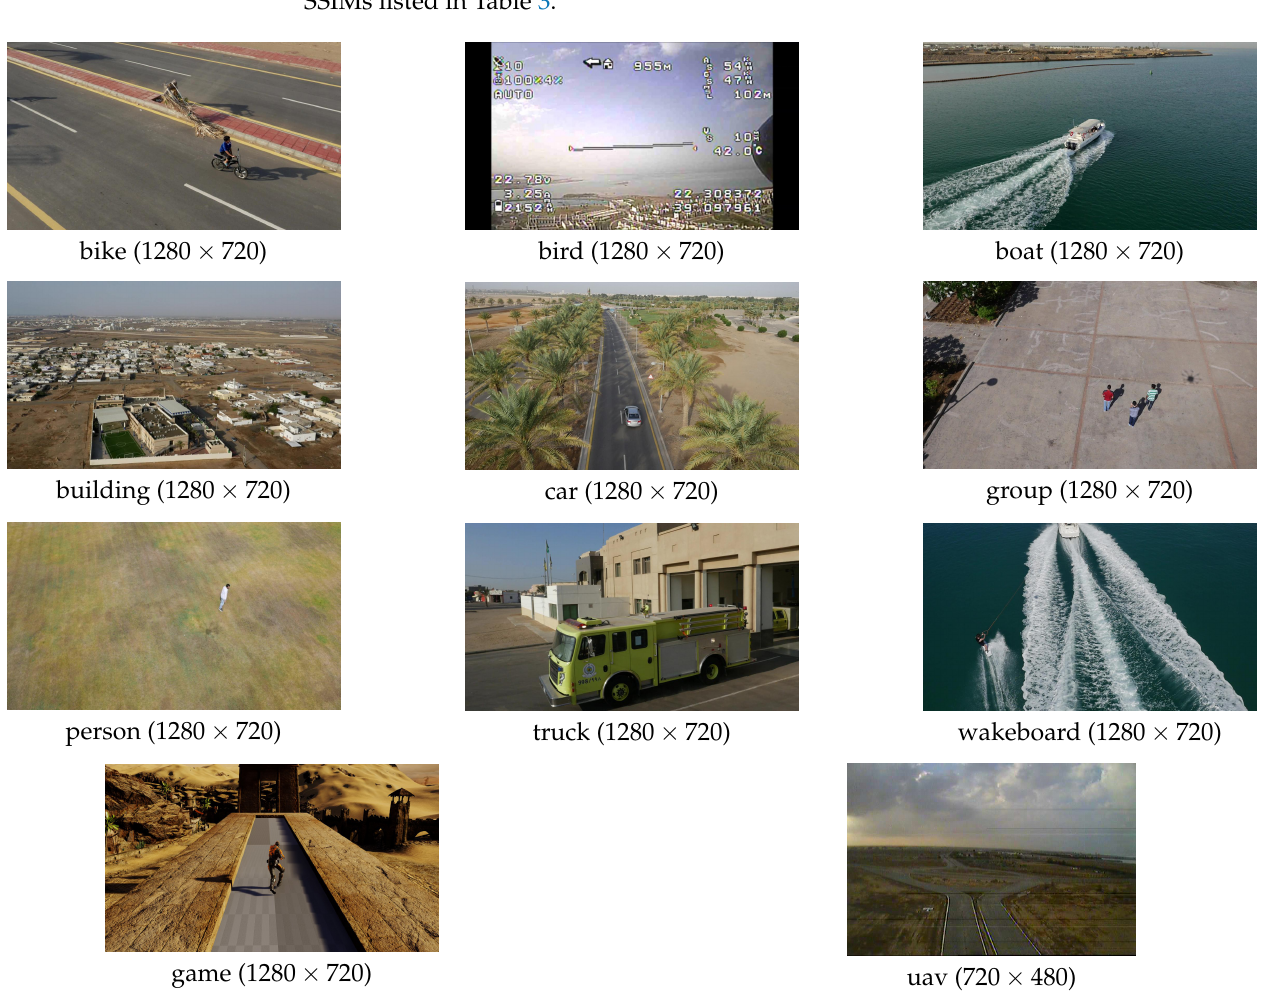
Figure 2. The original UAV images selected randomly from each eleven classifications of the “uav123”